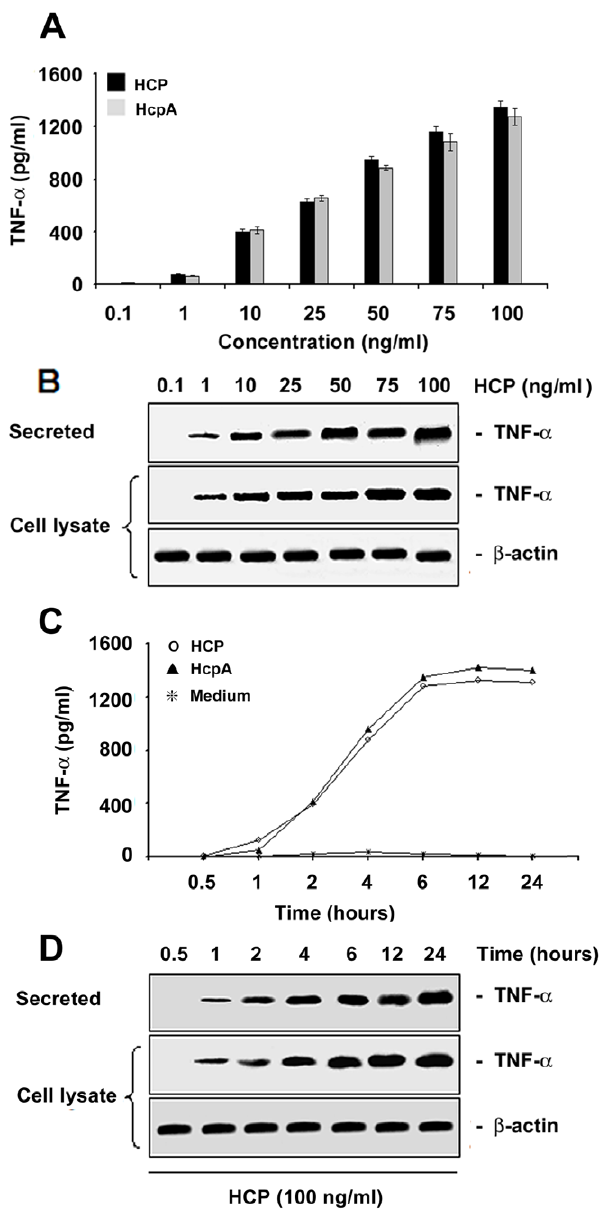
Figure 6. Induction of IL-8 release by purified HCP. IL-8 released in response to different concentrations of purified HCP and HcpA (A). Western blot showing the kinetics of secreted proteins and cell lysates produced after the incubation of polarized HT-29 cells with HCP and HcpA (B). IL-8 release after 6 h incubation of HCP with HT-29 cells (C). The supernatant recovered from the basolateral surface showed a significant time-dependent increase of IL-8 as shown by Western blotting (D). Detection of actin was used as a protein loading